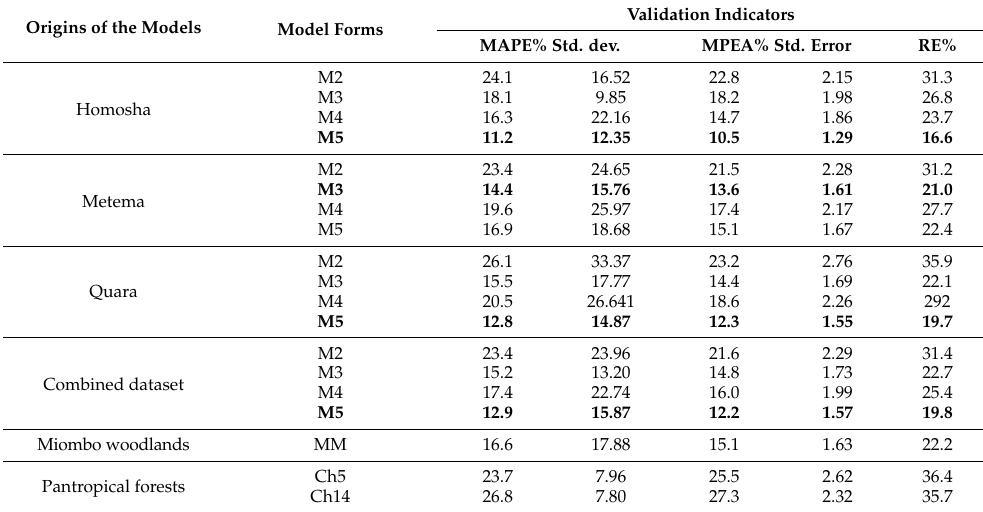
Table 4. Performance of mixed-species models resulted in bias in the plot and across-plot AGB estimates. Origins of the